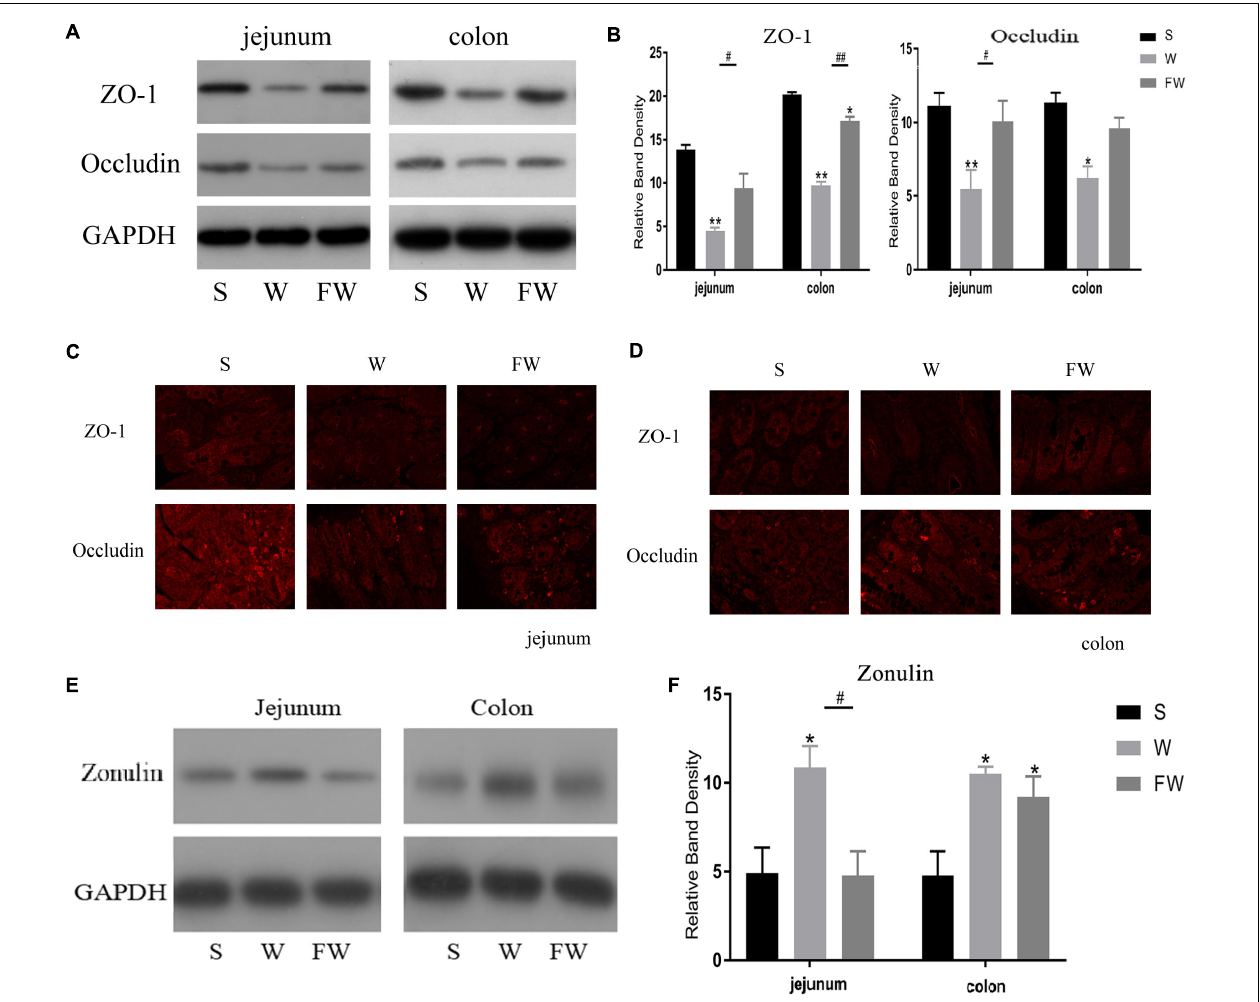
FIGURE 7 | Intestinal mucosal tight junction proteins expression of three groups. (A,B) Western blot measurements of the expression levels of ZO-1 and occludin in jejunum and colon. (C,D) The distributions of ZO-1 and occludin in jejunum and colon were determined by immunohistochemical staining (150 × ). (E,F) Western blot measurements of the expression levels of zonulin in jejunum and colon. The symbol “*” represented that the W and FW groups were compared with the S group, the symbol “#” represented that the FW group was compared with the W group. Data are shown as mean ± SEM for the three different experiments (* p < 0.05, ** p < 0.01, # p < 0.05, and ## p < 0.01) (S, Sucking; W, Weaned; FW,